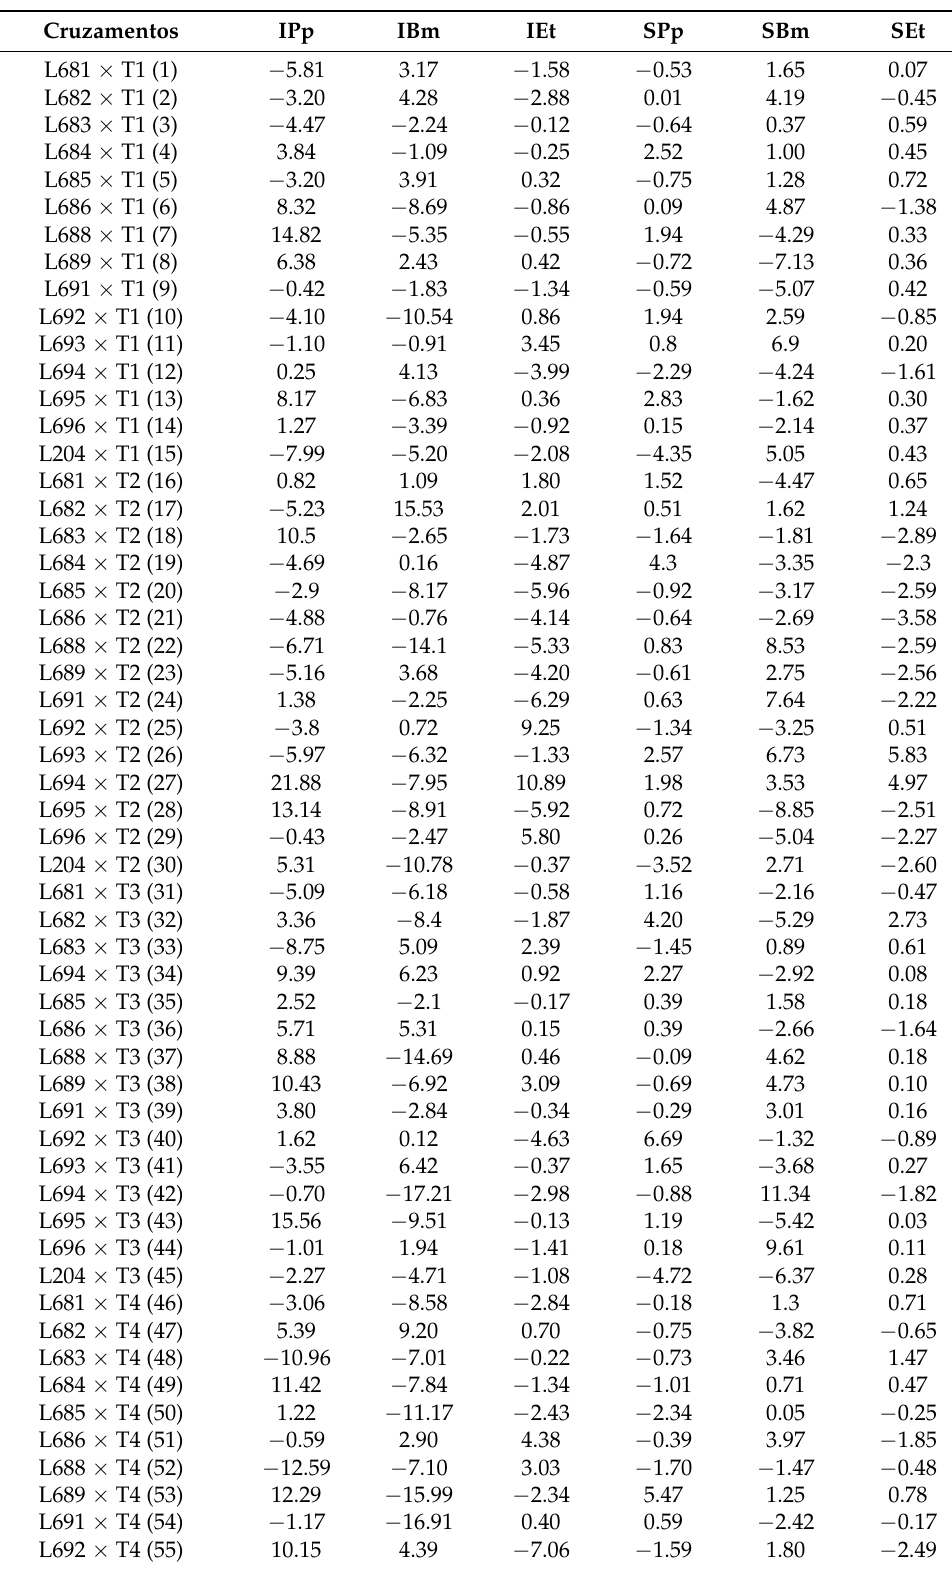
Table 4. Estimates of the specific combining ability (SCA) effects between the hybrids from fifteen S 7 progenies (Group I) and five testers (Group II) for the traits IPp, IBm, IEt, SPp, SBm, and SEt, evaluated in test crosses with popcorn under the partial diallel